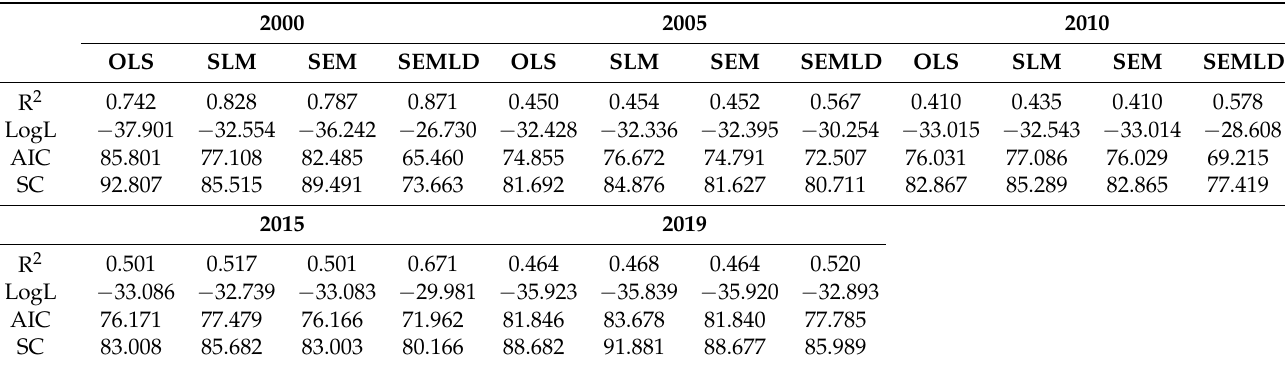
Table 2. Spatial regression results for total CO 2 emissions in China (five-time